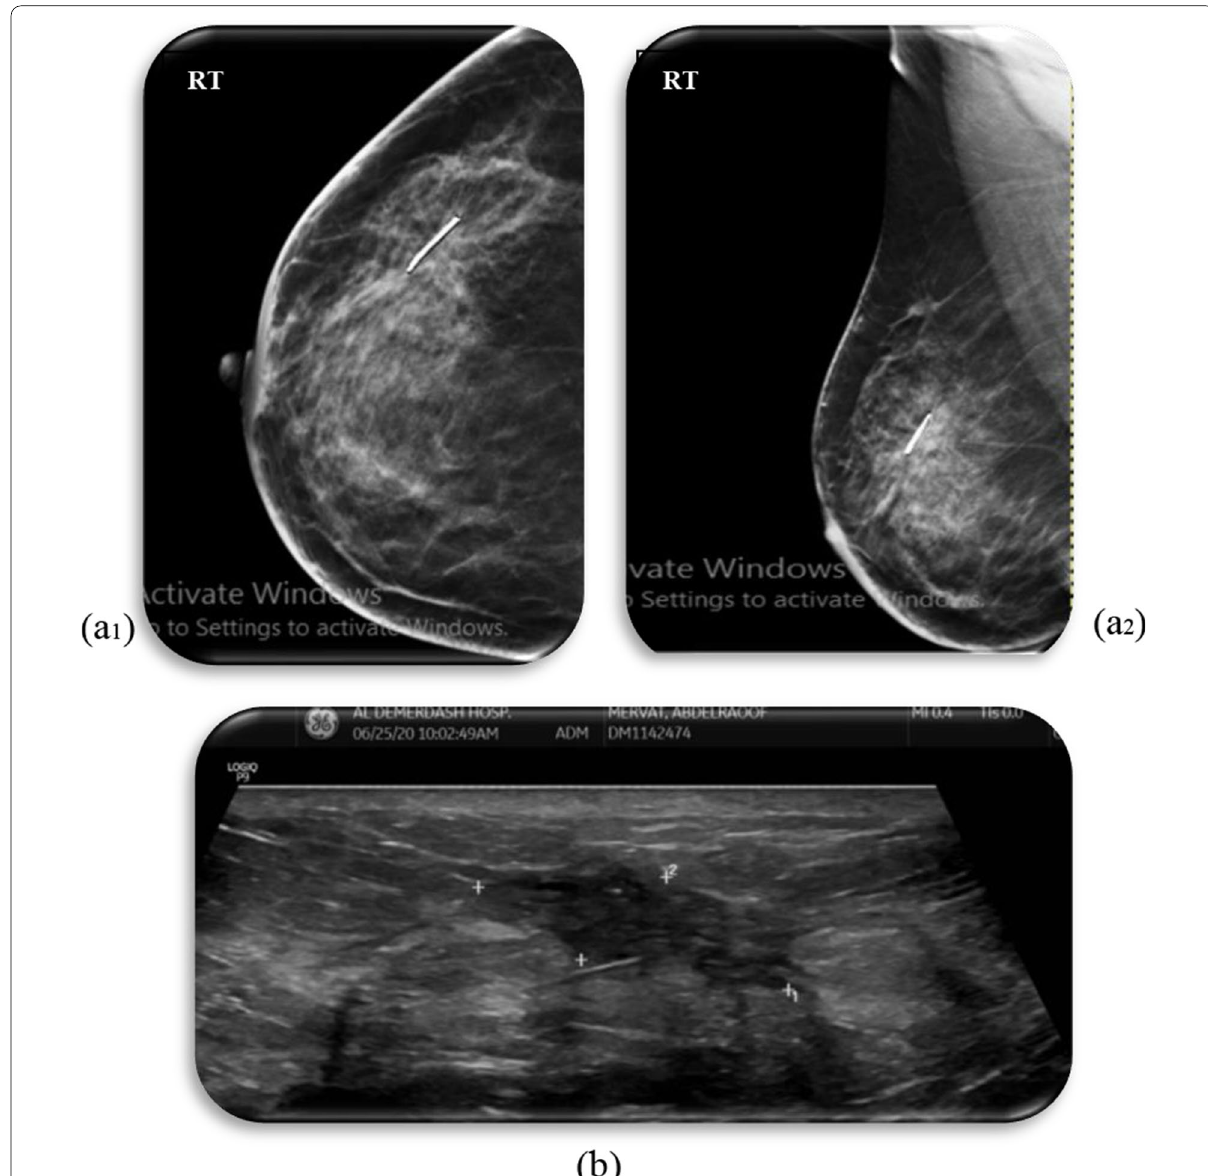
Fig. 6 40-year-old patient with recently pathologically proven invasive ductal carcinoma (IDC) grade II, planned for neoadjuvant chemotherapy came for metallic clip placement. Breast sonomamgraphy after clip placement a1 CC View, a2 MLO view and b ultrasound images showing the surgical clip seen within the upper outer quadrant mass lesion with no significant clip artifact interfering with the image interpretation or evidence of instant complications. MRI both breasts c1 T1WIs, c2 T2WIs and c3 post contrast images done after one month of clip insertion and after start of neoadjunvant chemotherapy showing small signal void due to the clip observed in the center of the proven malignant lesion yet there was no difficulty in characterization of the lesion. After completing the course of neoadjuvant therapy, follow up sonomamography was done d1 CC views, d2 MLO view and d3 ultrasound images showing the regressive course as regards the right side upper outer breast lesion where the surgical clips are seen at the lateral end of the remaining lesion as seen on the ultrasound images where the clip seen in-place on sonomamography